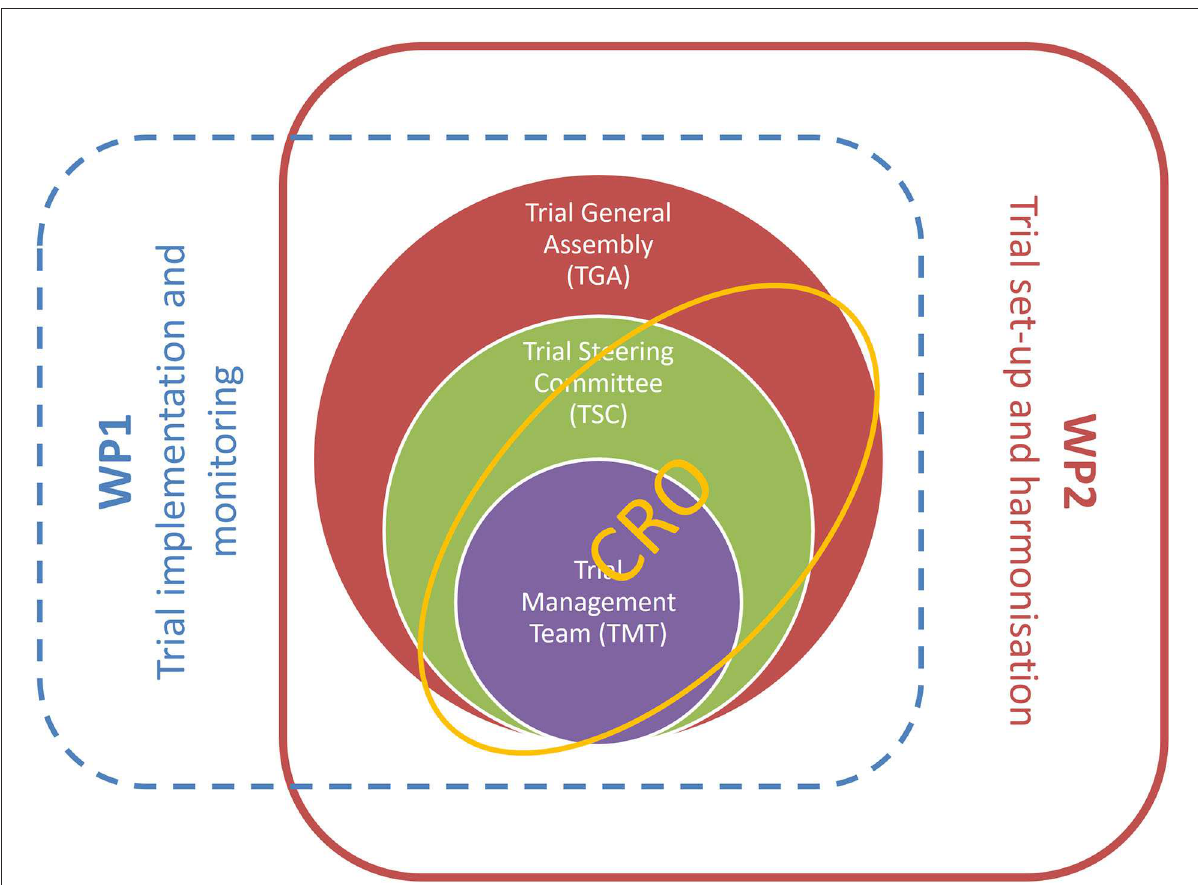
FIGURE4 Trial management structure is nestled into activities of workpackages 1 and 2 of the TUDCA-ALS consortium. Workpackage 1 is responsible for trial implementation and monitoring, and workpackage 2 is dedicated to trial setup and harmonization. These core activities are implemented through intertwined interactions between the Trial Management Team, the Trial General Assembly, the Trial Steering Committee, and the contract research